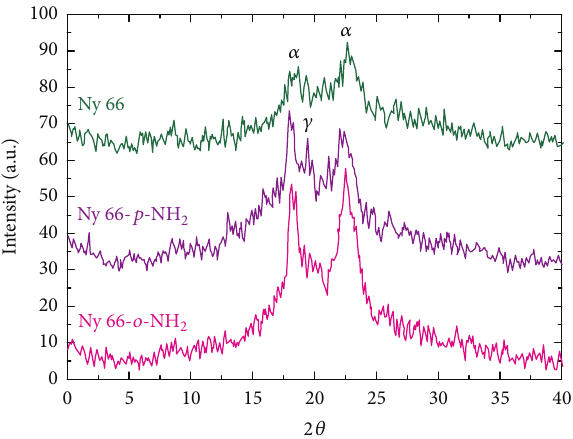
Figure 7: X-ray diffraction spectra of the Nylon 66, Ny 66- o -NH 2 , and Ny 66- p -NH 2